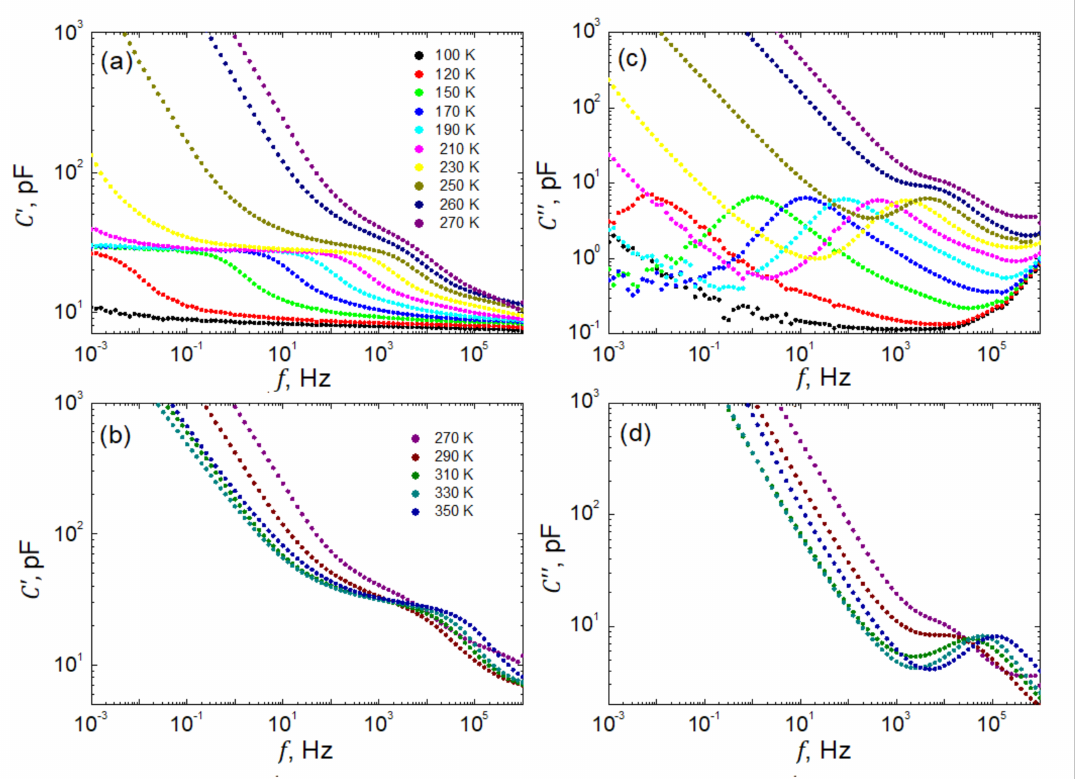
Figure 5. Representatively selected frequency dependences of real, C (cid:48) , ( a , b ) and imaginary, C (cid:48)(cid:48) , ( c , d ) parts of the complex capacitance of SbSI sample at temperatures T ≤ 270 K ( a , c ) and T ≥ 270 K ( b , d